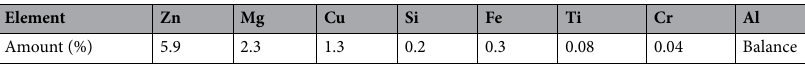
Table 1. Elemental composition of Al 7075 alloy used in the study.